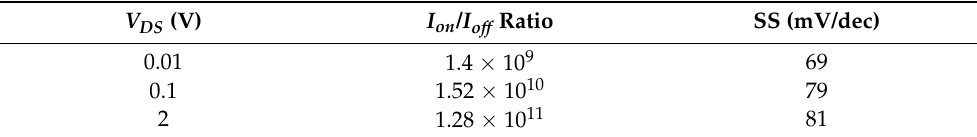
Table 1. Electrical parameters of the Vertical MOSFET.